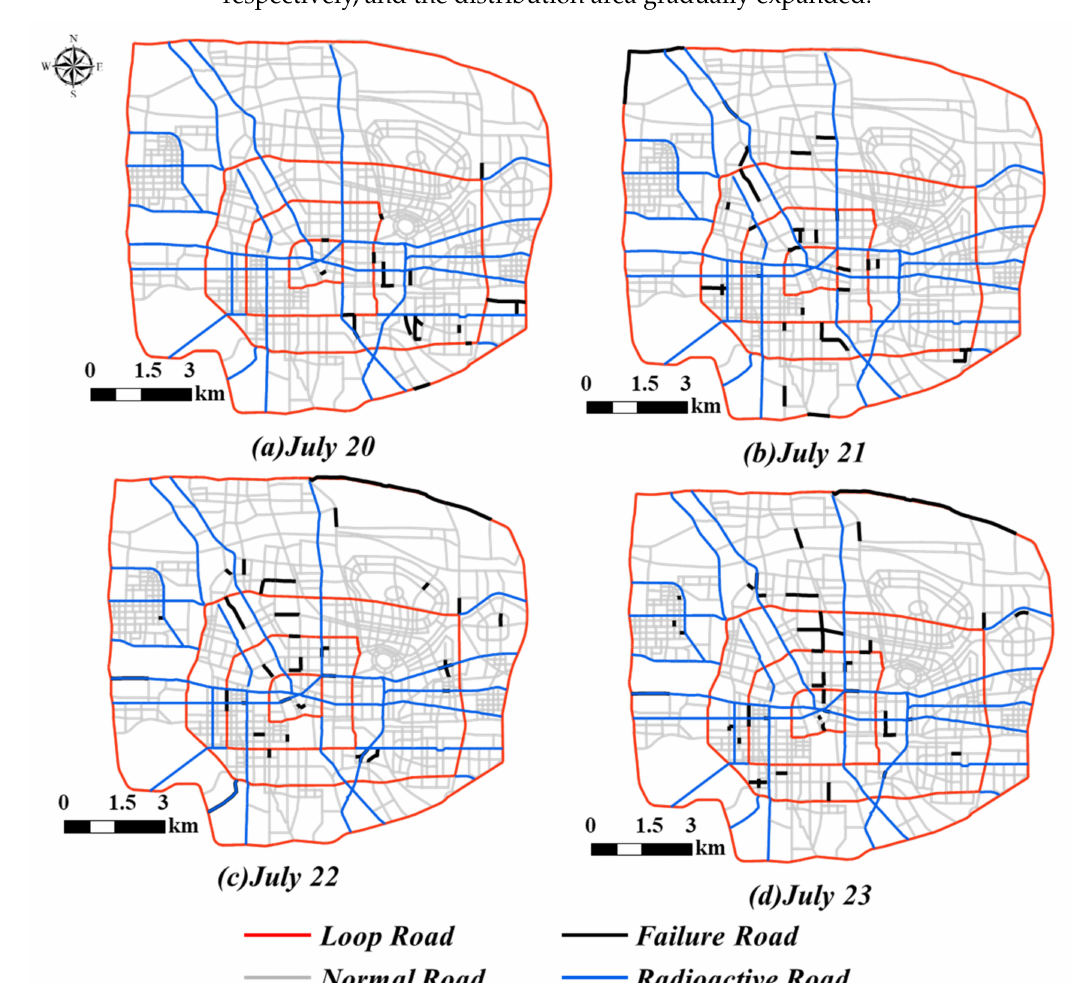
Figure 2. Failure Road location during the